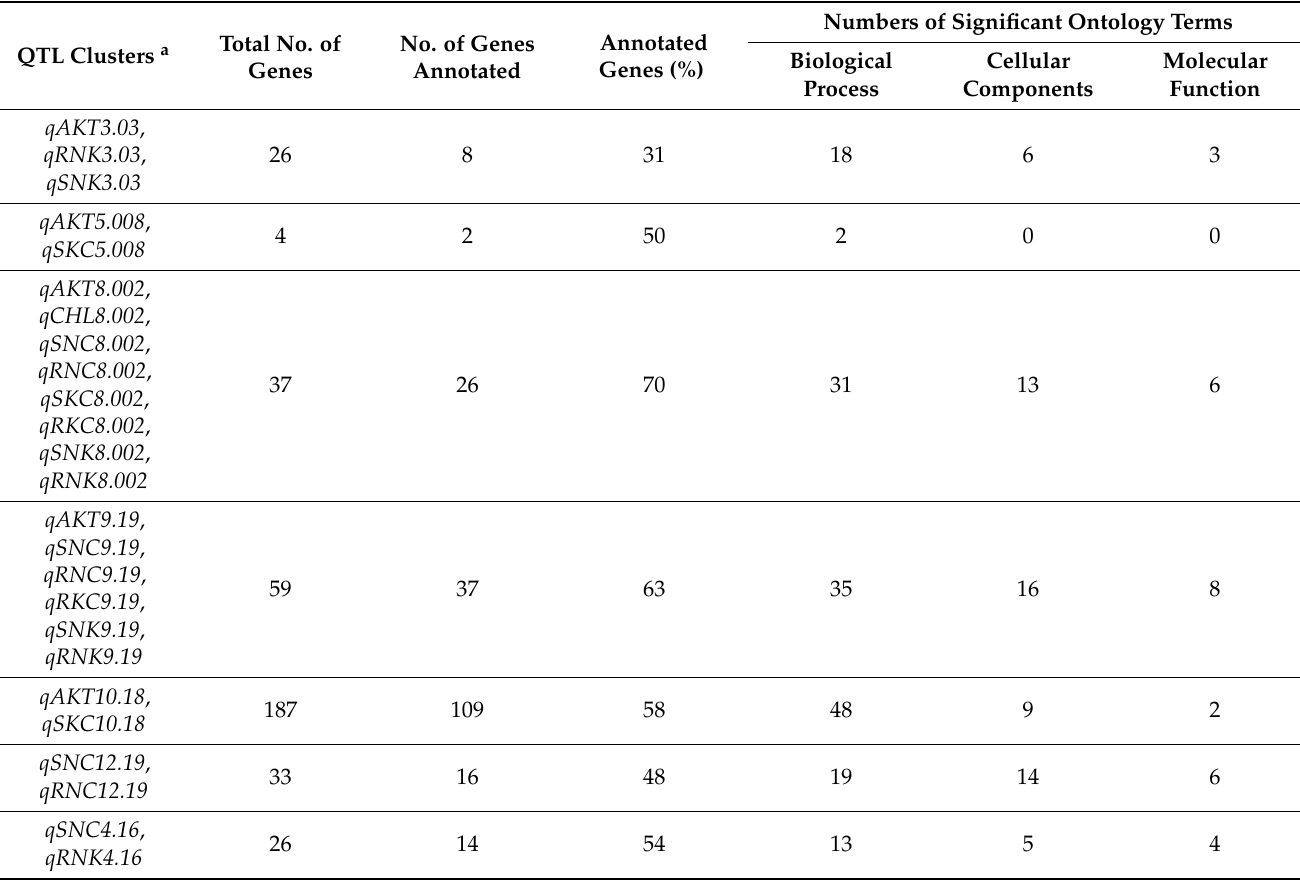
Table 5. Gene ontology analysis of clustered QTL for alkaline stress responsive traits.